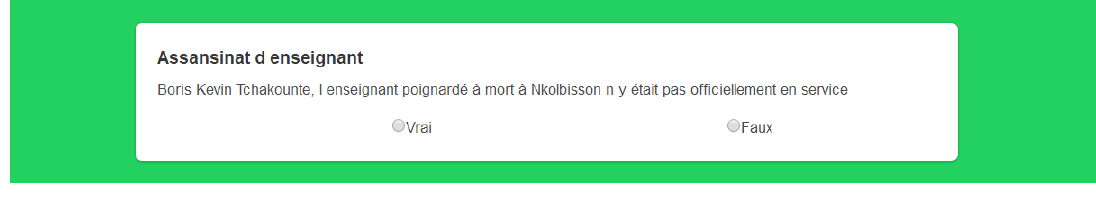
Figure 6. Voting post in the form.